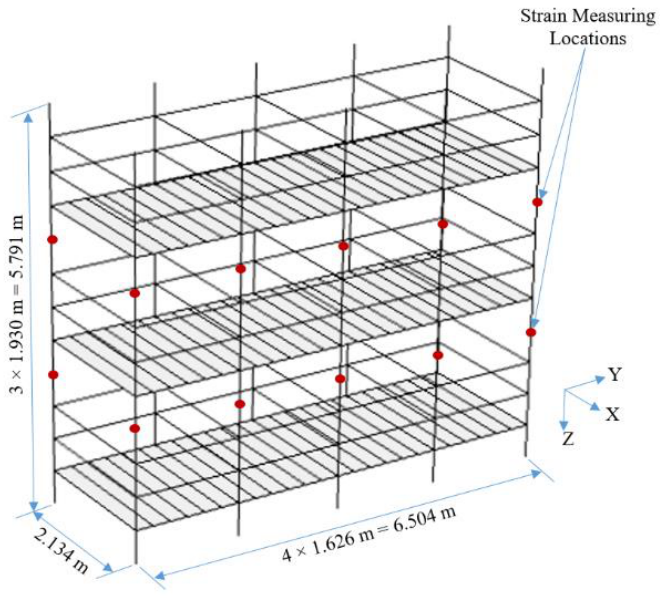
Figure 2. Sca ff old Figure 2. Scaffold model.